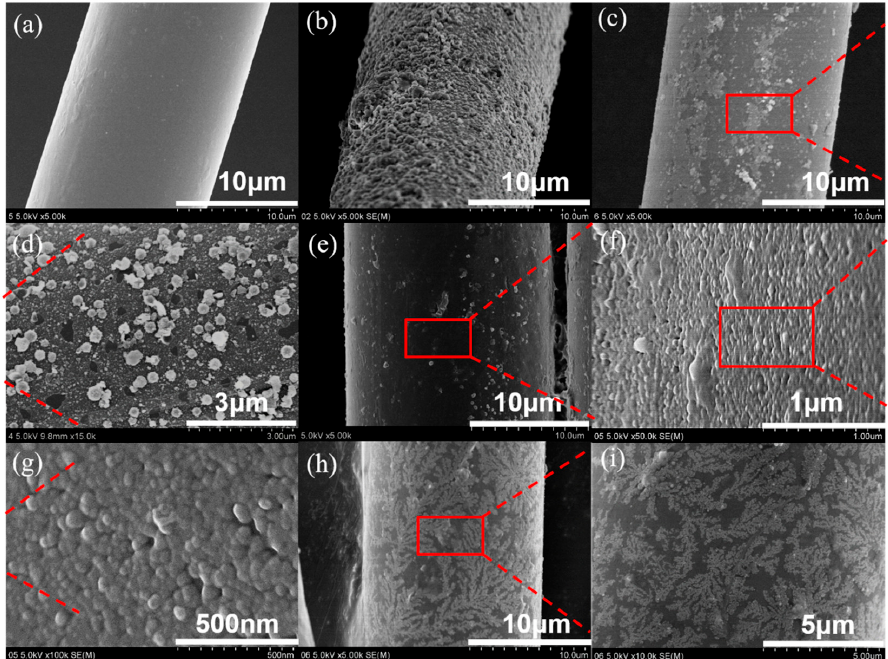
Figure 6. SEM images: AFs ( a ); AFs-SiO 2 -10MPa ( b ); AFs-SiO 2 -12MPa ( c, d ); AFs-SiO 2 -14MPa ( e–g ), and AFs-SiO 2 -16MPa ( h, i ).